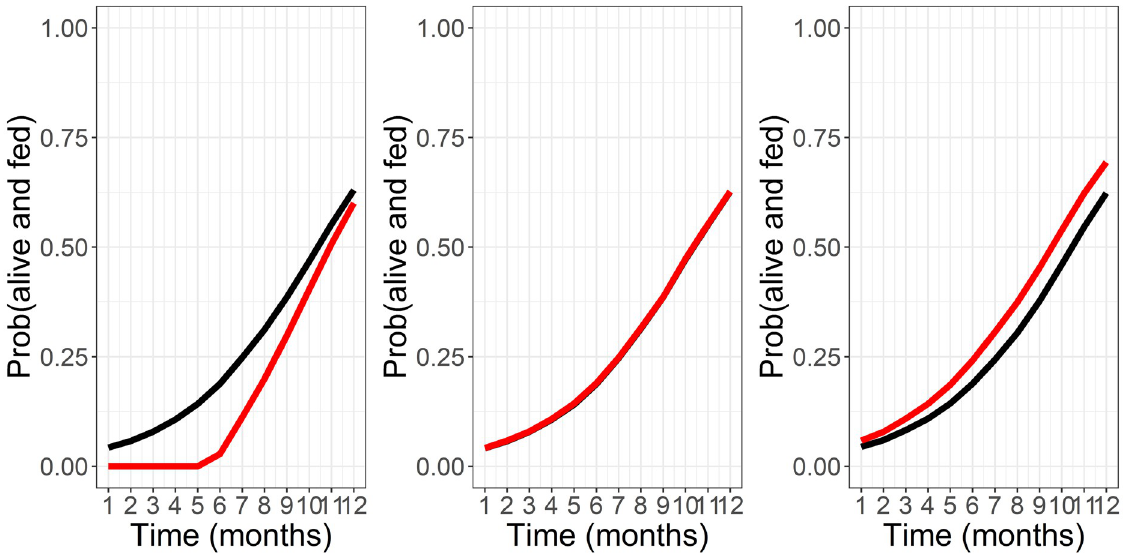
Fig 6. Probability of success (alive) and fed over time for independent and joint models using simulated trial data. A copula method is used to impose correlation. The black lines are the Independent estimates and the red lines are the correct joint estimates. The estimates are based on the empirical marginal probabilities. a) negative correlation. b) independent c) positive correlation (as is the case for the experimental hut data examined here).